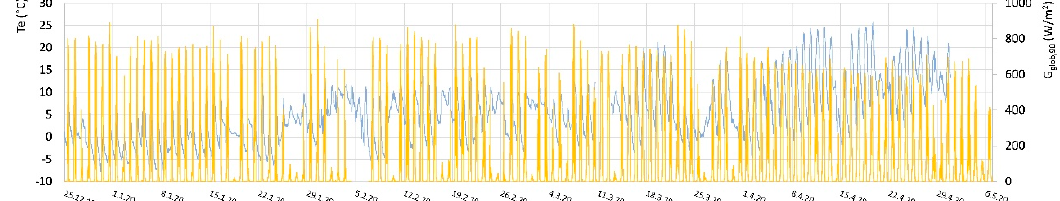
Figure 3. Solar irradiation received by BIPV G glob,90 and outdoor air temperature T e , which occurred during the during the experiment. Table 1. Average and extreme values of meteorological variables during the duration of the experiment.